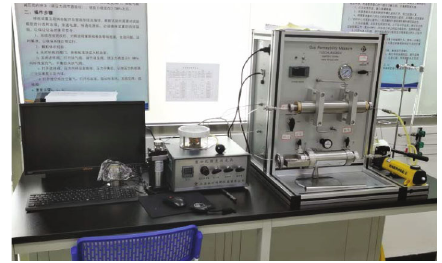
Figure 4: Core conventional pore permeameter.